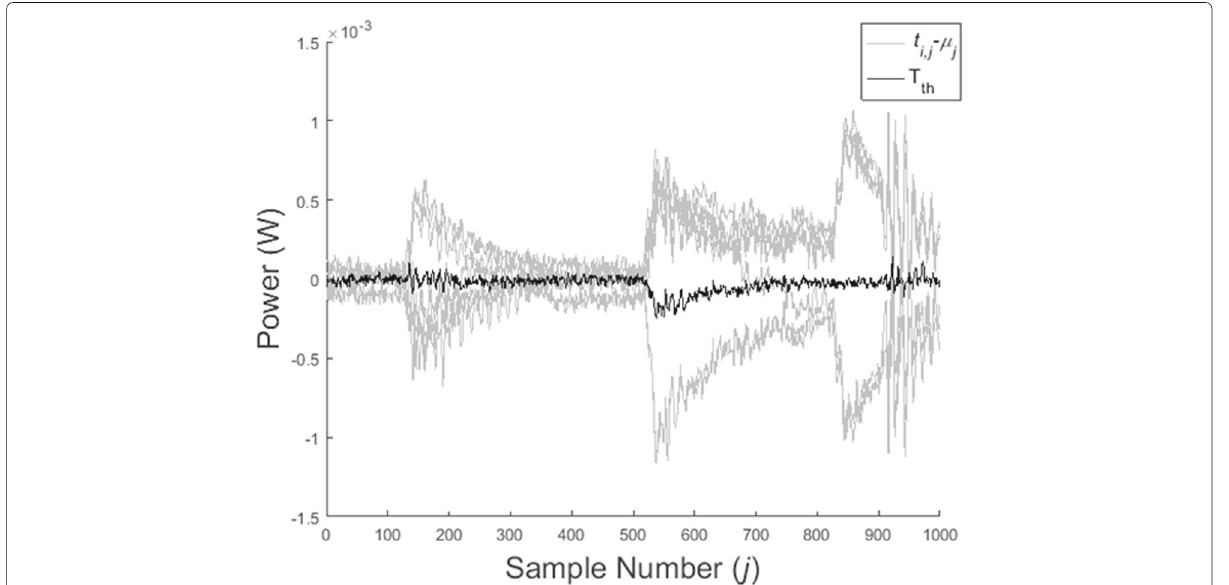
Fig. 8 Threshold values. T th for every sample in recorded traces